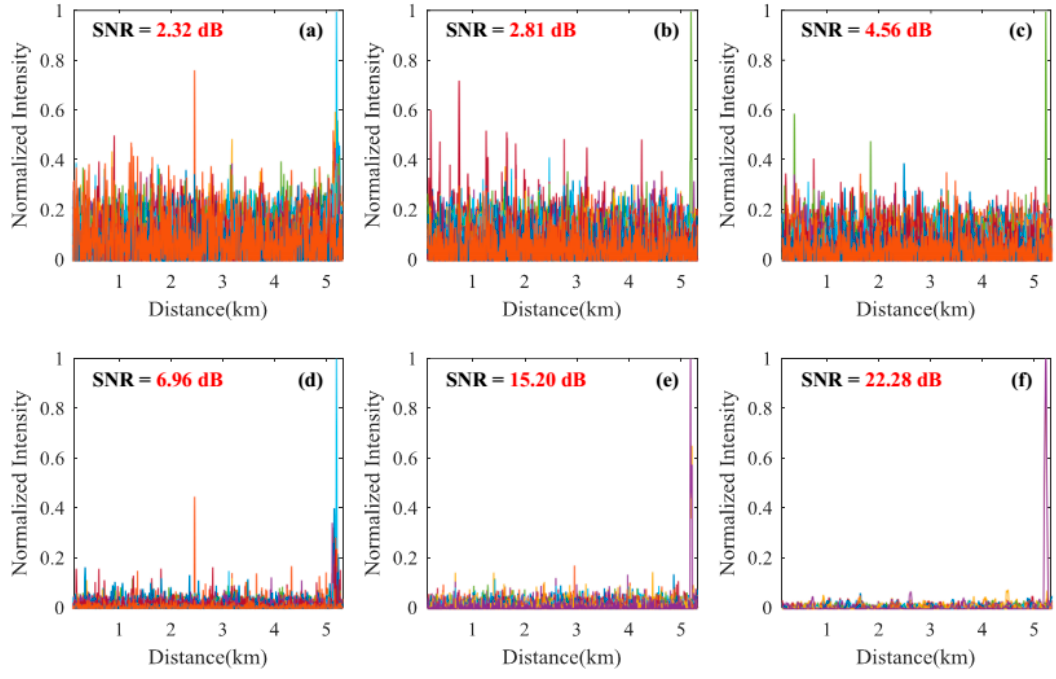
Figure 6. The locating results of pencil-break under 500 ns pulse width. ( a ) The result of MAD method; ( b ) The result of TED method; ( c ) The result of MWD method; ( d ) The result of WD method; ( e ) The result of SK method; ( f ) The result of SAK method.